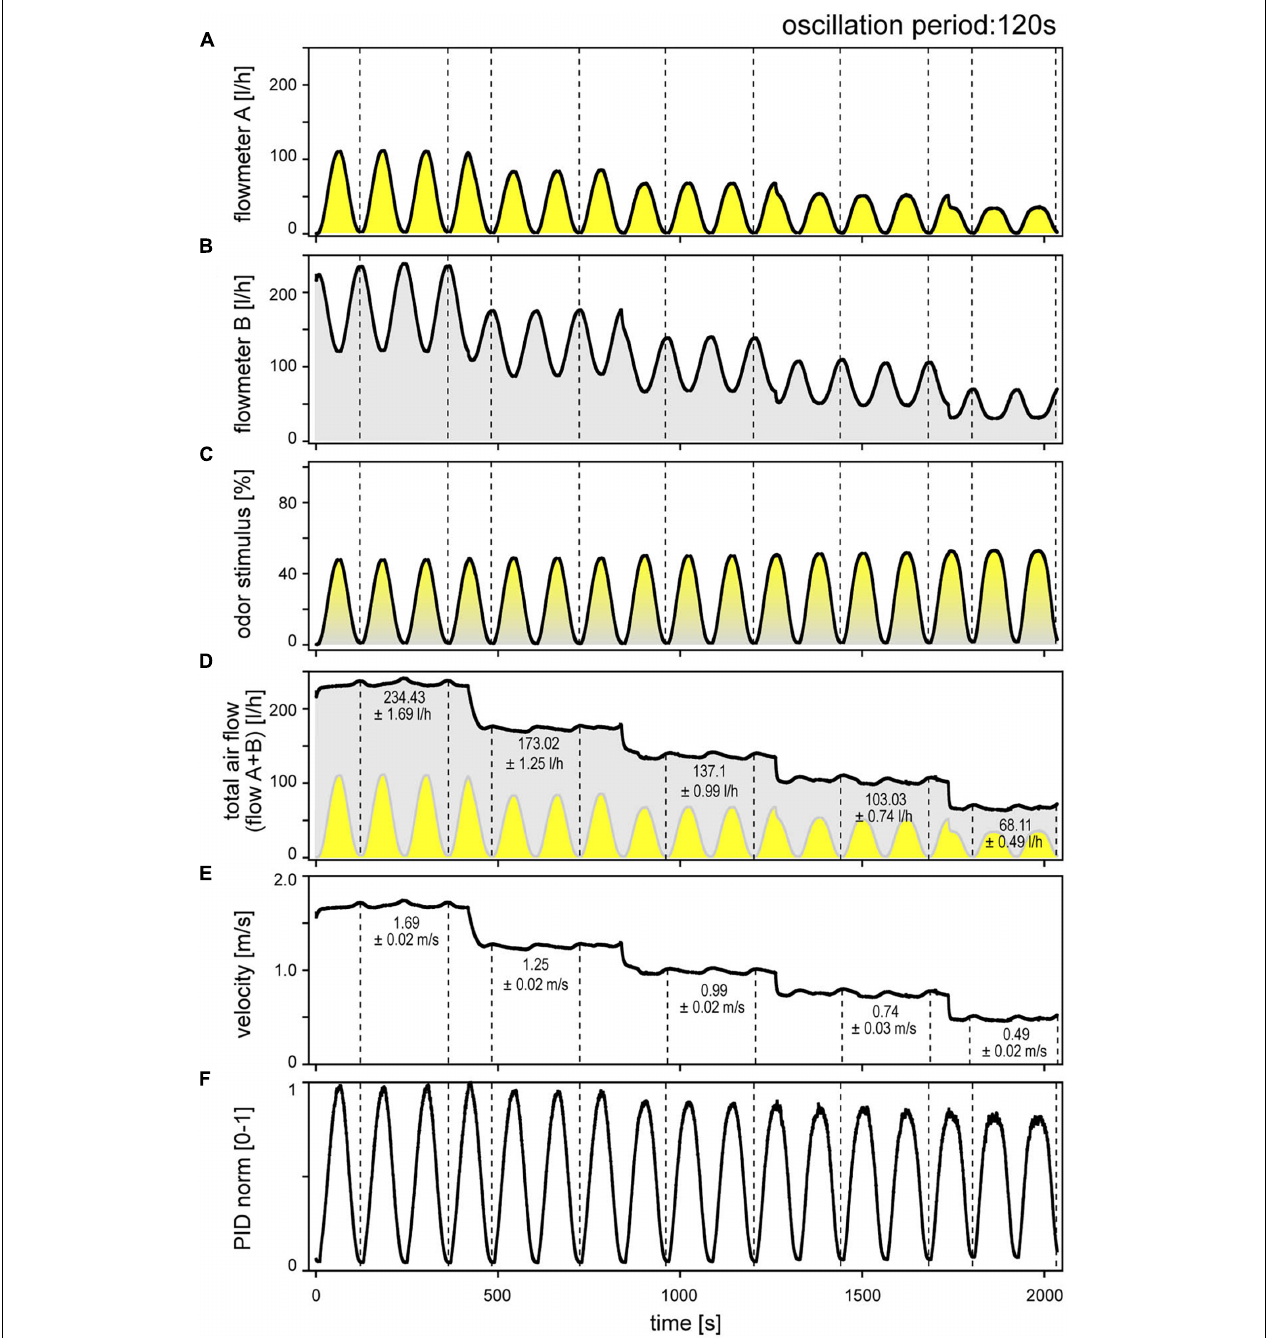
FIGURE 1 | Sinusoidal concentration changes at constant period of 120 s, delivered at five different, stepwise reduced air flow velocities. (A) Flowmeter A signals the time course of the odor-saturated air stream controlled by proportional valve A . (B) Flowmeter B signals the time course of the clean air stream controlled by proportional valve B . The control voltages of both valves were 180 ◦ phase-shifted. In order to maintain constant amplitude of the sinusoidal concentration changes when the flow velocity was decreased, the flow rates of both air streams were reduced accordingly. (C) Time course of sinusoidal concentration changes determined by the mixing ratio of odor-saturated air in clean air and expressed as percentage of saturated air. (D) Time course of summed flow rates of the odor-saturated air stream A (yellow oscillations) and the clean air stream B (gray oscillations, inverse to yellow oscillations); averaged values were determined for the periods indicated by dotted lines. (E) Time course of the flow velocity of the mixed air stream, calculated from the total flow rate of the two air streams in panel (D) . Periodic low-amplitude fluctuations in air flow velocity reflect fluctuations in the total air flow rate; they had no effect on ORN responses. Averaged values were determined for the periods indicated by dotted lines. (F) Normalized time course of the sinusoidal PID signal corresponds with the flowmeter signal in panel (C) ; note slow decrease in amplitude with decreasing flow velocity.